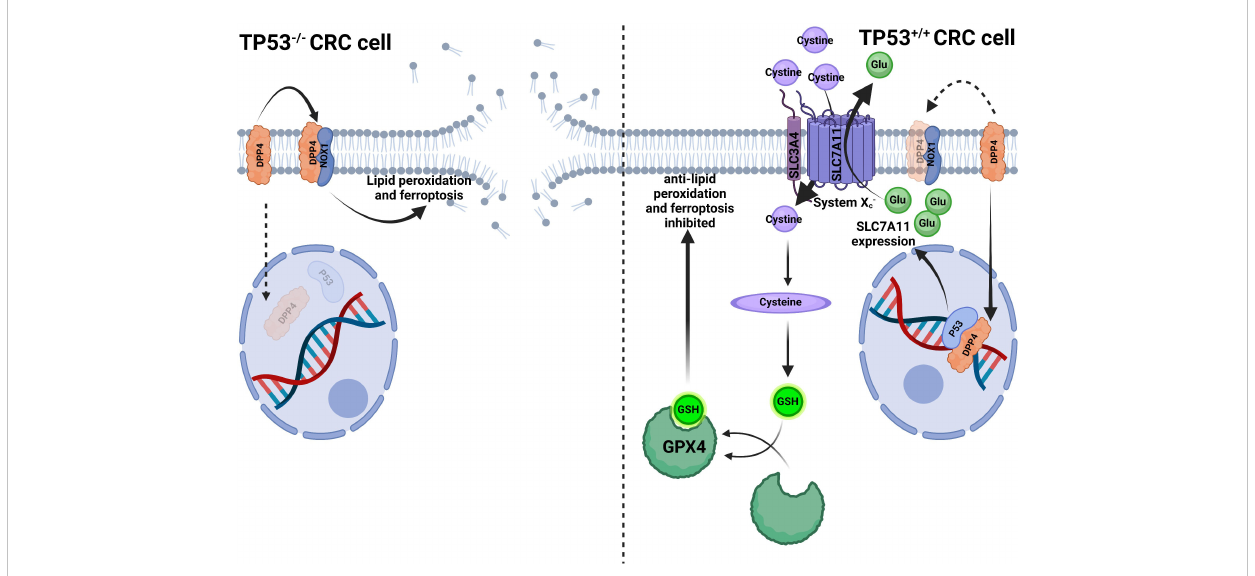
FIGURE 4 P53 inhibits ferroptosis in CRC cells. In TP53 -/- CRC cells, DPP4 could not translocate into the nucleus to bind to P53 but remains in the plasma membrane and contacts with NOX1 to induce lipid peroxidation and ferroptosis. In TP53 +/+ CRC cells, DPP4 translocated into the nucleus to bind P53, facilitating SLC7A11 transcription and enhanced X C − function, thus, transferring more cystine into the cytoplasm and increasing glutathione (GSH) synthesis. Increased GSH enhanced GPX4 activity to compete with lipid peroxidation and ferroptosis